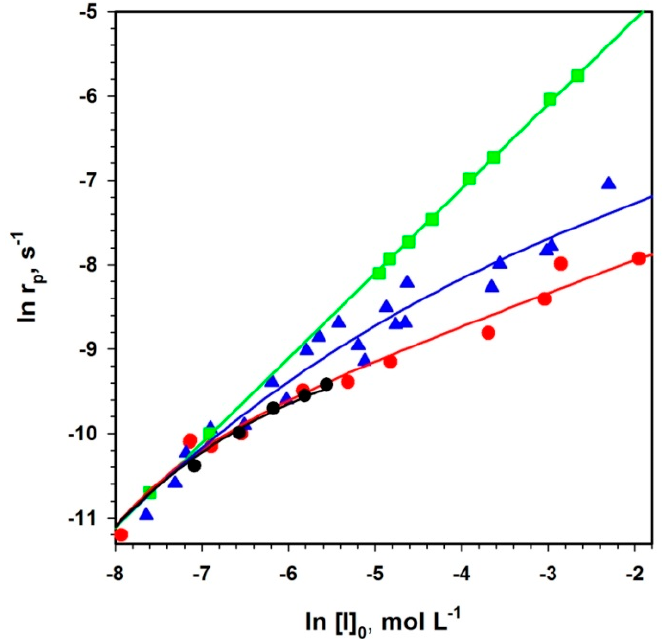
Figure 2. Bilogarithmic dependencies of the relative rates of polymerization ( r p ) of ε -caprolactone initiated with dialkyaluminum alkoxides on the starting concentrations of initiator ([ I ]) 0 , showing influence of aggregation on the kinetics of the polymerization. Conditions: THF solvent, 25 °C, [ ε -CL] = 2 mol·L − 1 . Points experimental for initiators: blue triangles ( ▲ ), (C 2 H 5 ) 2 AlOC 2 H 5 ; red circles ( ● ), [(CH 3 ) 2 CHCH 2 ] 2 AlOCH 3 ; black circles ( ● ), (C 2 H 5 ) 2 AlOCH 2 CH=CH 2 ; green squares ( ■ ), (C 2 H 5 ) 2 AlOCH 2 CH=CH 2 /(CH 3 )NCH 2 CH 2 NH(C 2 H 5 ) (1/2 mole ratio). Experimental data have been taken from [41].